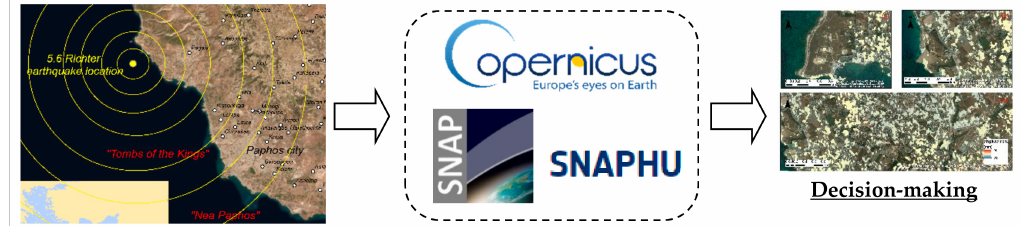
Figure 6. The contribution of Copernicus, ESA, and Stanford University on natural hazards monitoring and the protection of cultural